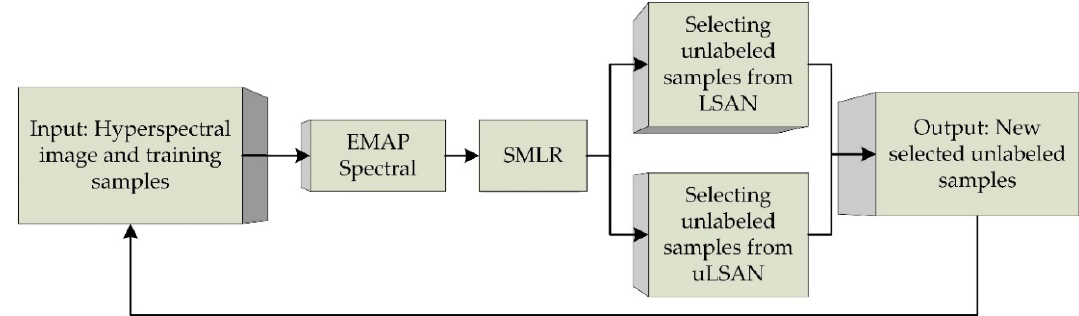
Figure 2. Flowchart of the unlabeled samples selection of our proposed shape adaptive neighborhood information based semi-supervised learning (SANI-SSL).